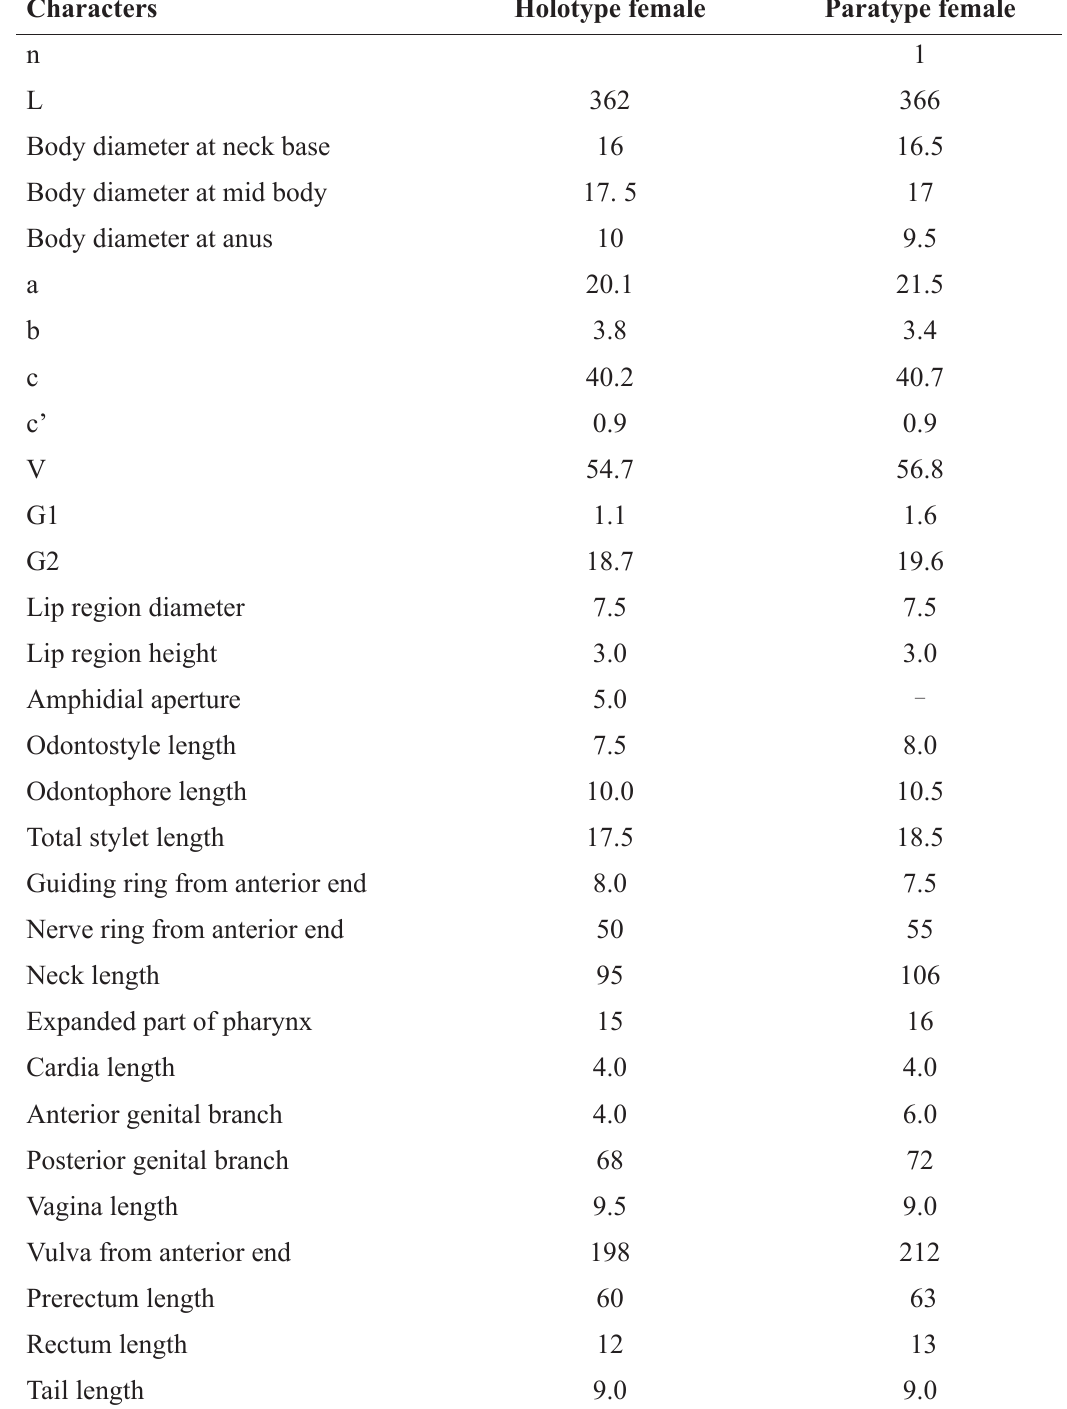
Table 11. Measurements of Basirotyleptus siddiqii sp. nov. All measurements are in μm.